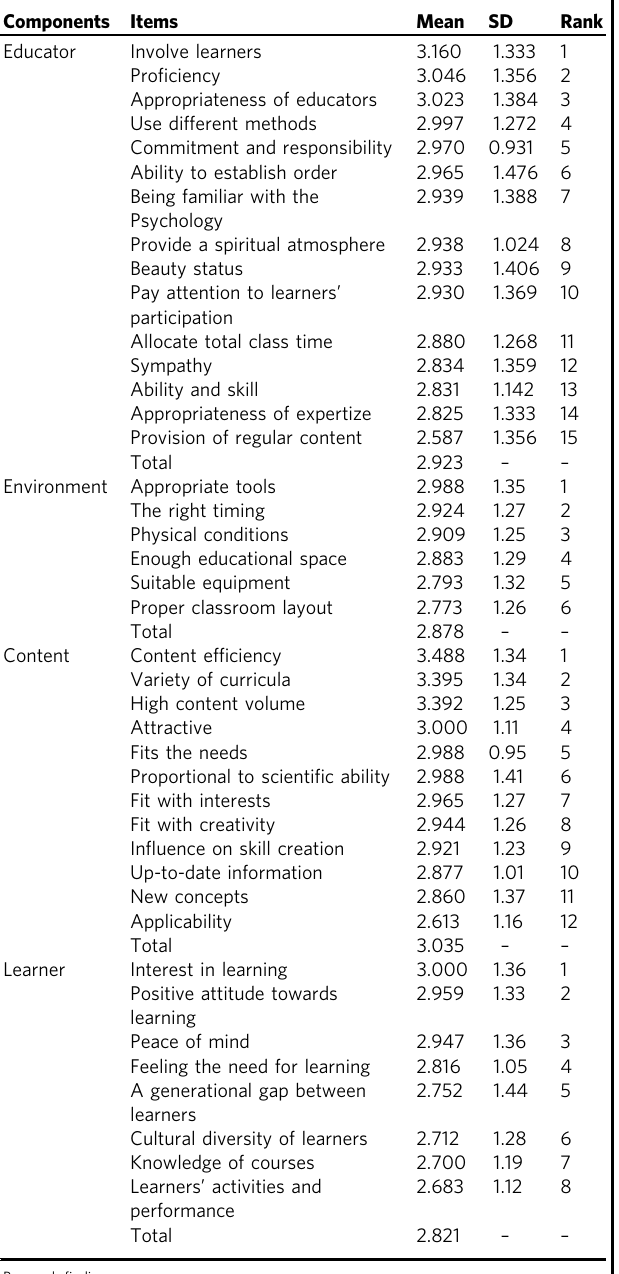
Research fi ndings.